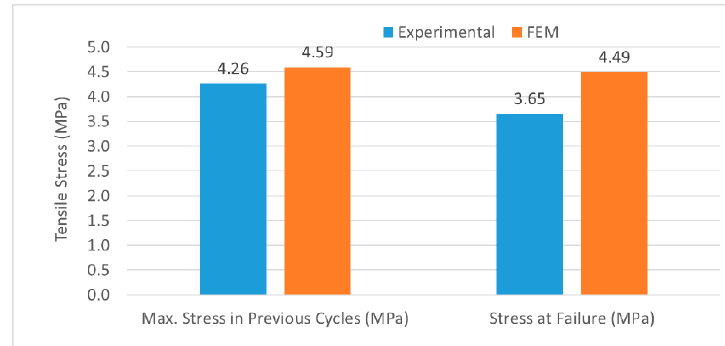
Figure 11. Comparison between FEM and experimental results for Specimen No. 17.